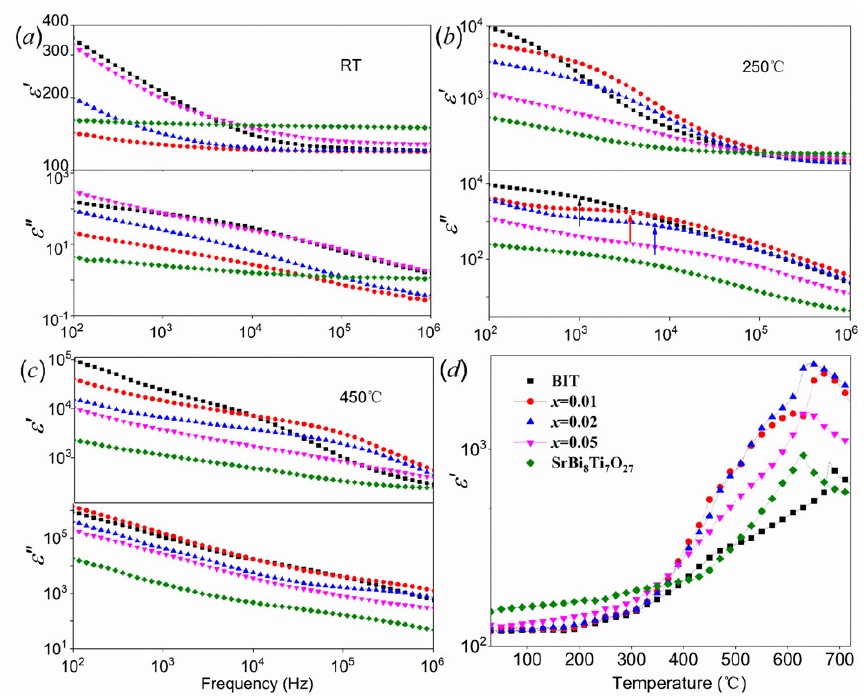
 and  of SBIT ceramics at various temperatures: (a) room temperature, (b) 250 ℃ , (c) r r